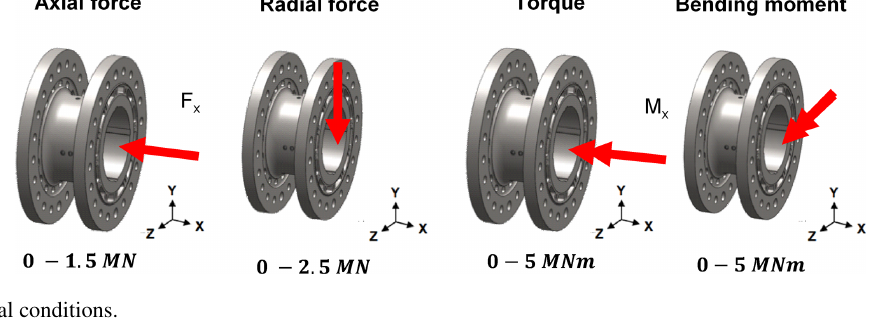
Figure 9. Operational conditions.